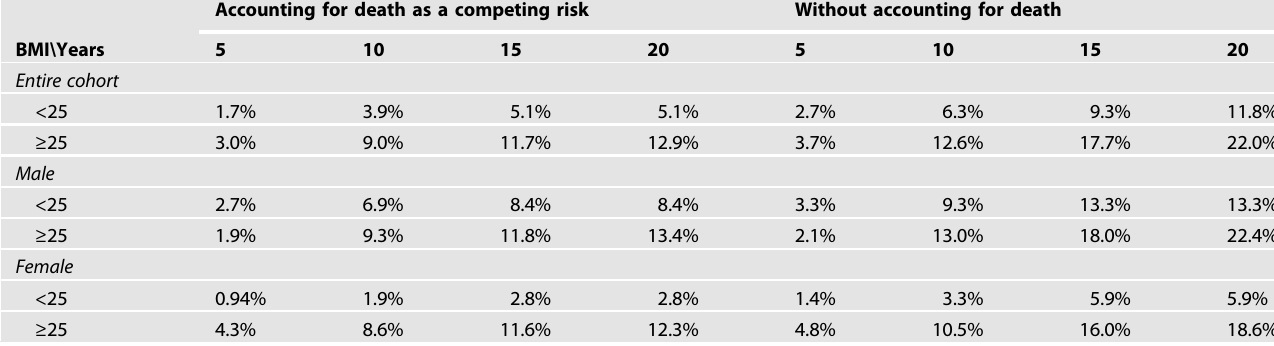
Table 3. Cumulative incidence rates of MGUS progression by BMI and